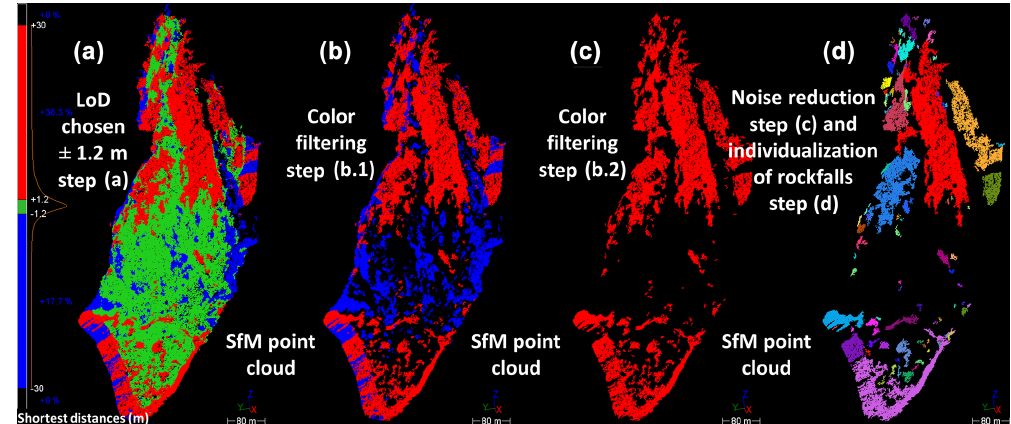
Figure 4. Rockfall extraction method. (a) Result of the point-to-mesh comparison between the SfM point cloud and the reference lidar mesh. Same result as in Fig. 3a but displayed with three colors and a LoD of ± 1.2m. Red color: positive deviations; green color: points between ± 1.2m; and blue color: negative deviations. (b) Filtering of the green color (first step). (c) Filtering of the blue color (second step). (d) Rockfall extraction and individualization. Each color corresponds to an individual point cloud. The points associated with the Bonatti Pillar collapse are highlighted in red.